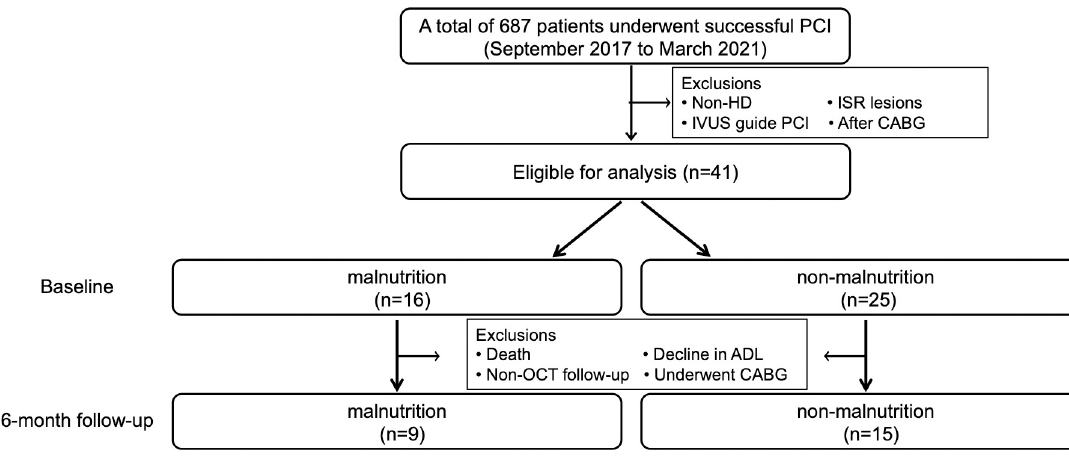
Fig 1. Description of non-culprit